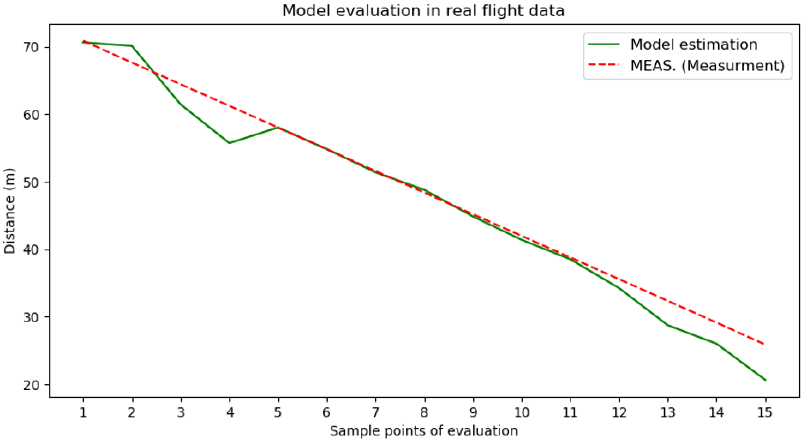
Figure 28. Result of model evaluation in Experiment 3. Table 8. Experiment 3 (estimation vs. GPS measurement).